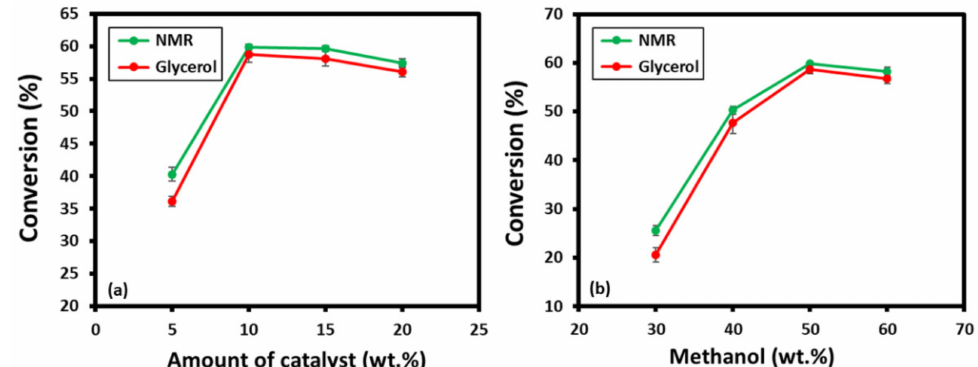
Figure 7. Conversion of UVO in the presence of MOF-801 as catalysts using different reaction parameters ( a ), at varying catalyst loading. (Green line conversion based on NMR and red line conversion based on the yield of glycerol) and ( b ) using different amounts of CH 3 OH with respect to oil.